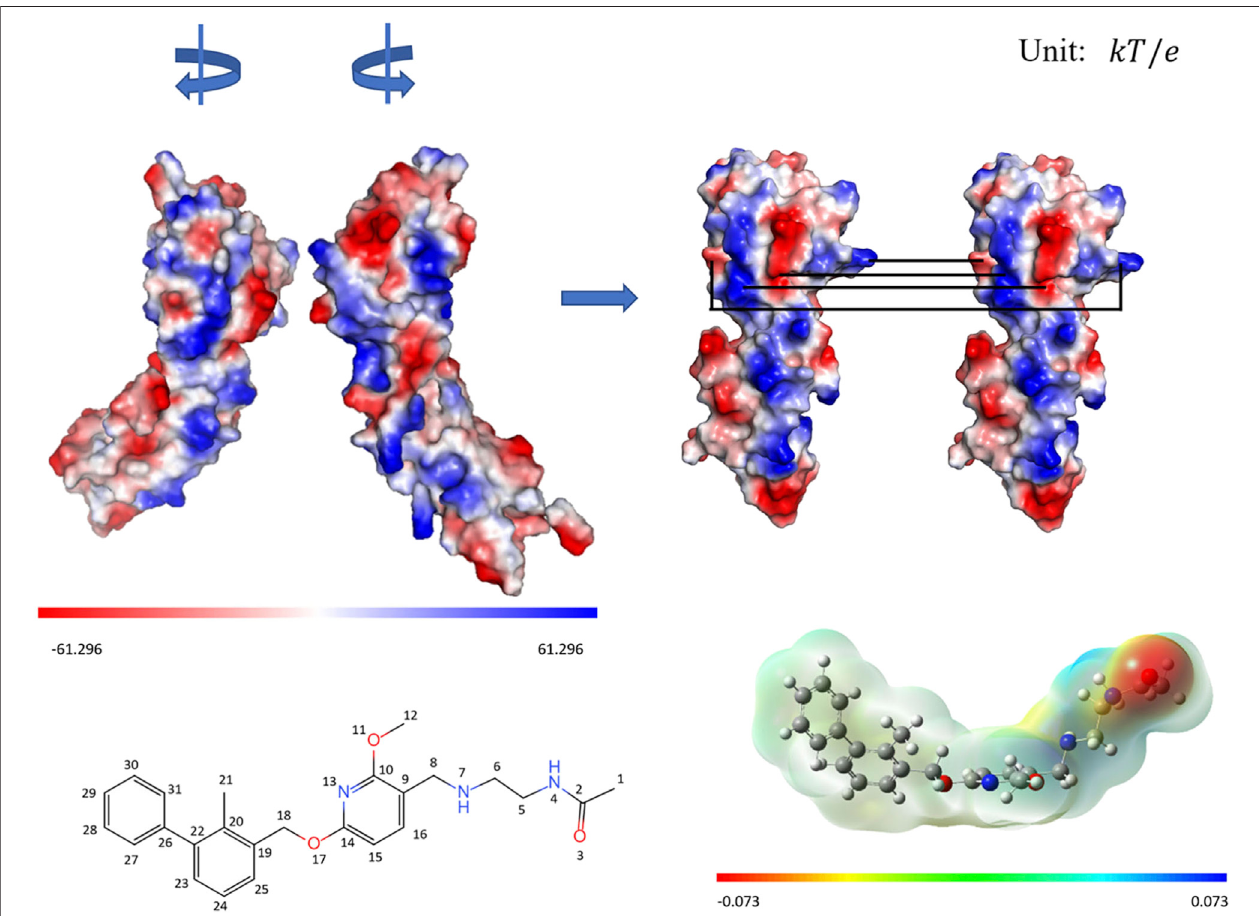
FIGURE4| ThesurfaceelectrostaticpotentialofPD-L1anddrugmoleculeBMS-202.TherelativeorientationofPD-L1sin5J89systemsatis fi estheC 2v symmetry, and itwillsatisfy thetranslation symmetryifwerotatetheleftmonomer90 ° clockwiseand therightmonomer 90 ° counterclockwise.Foreaseofviewing,theelectrostatic opposite-matching regions of the PD-L1s are linked in pairs by black lines. The surface electrostatic potential and the 2D structure with the atomic numbers of the drug BMS-202 are shown respectively.